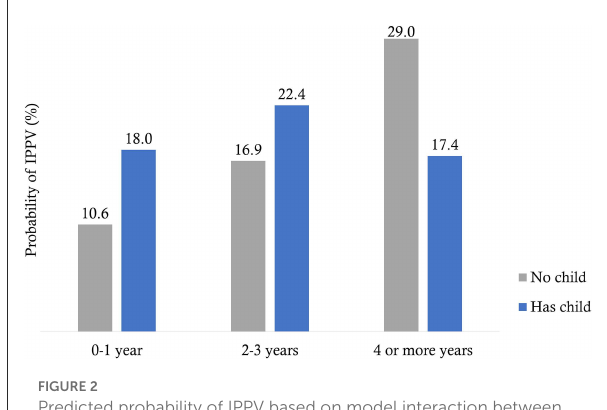
FIGURE2 Predicted probability of IPPV based on model interaction between marriage duration and having a